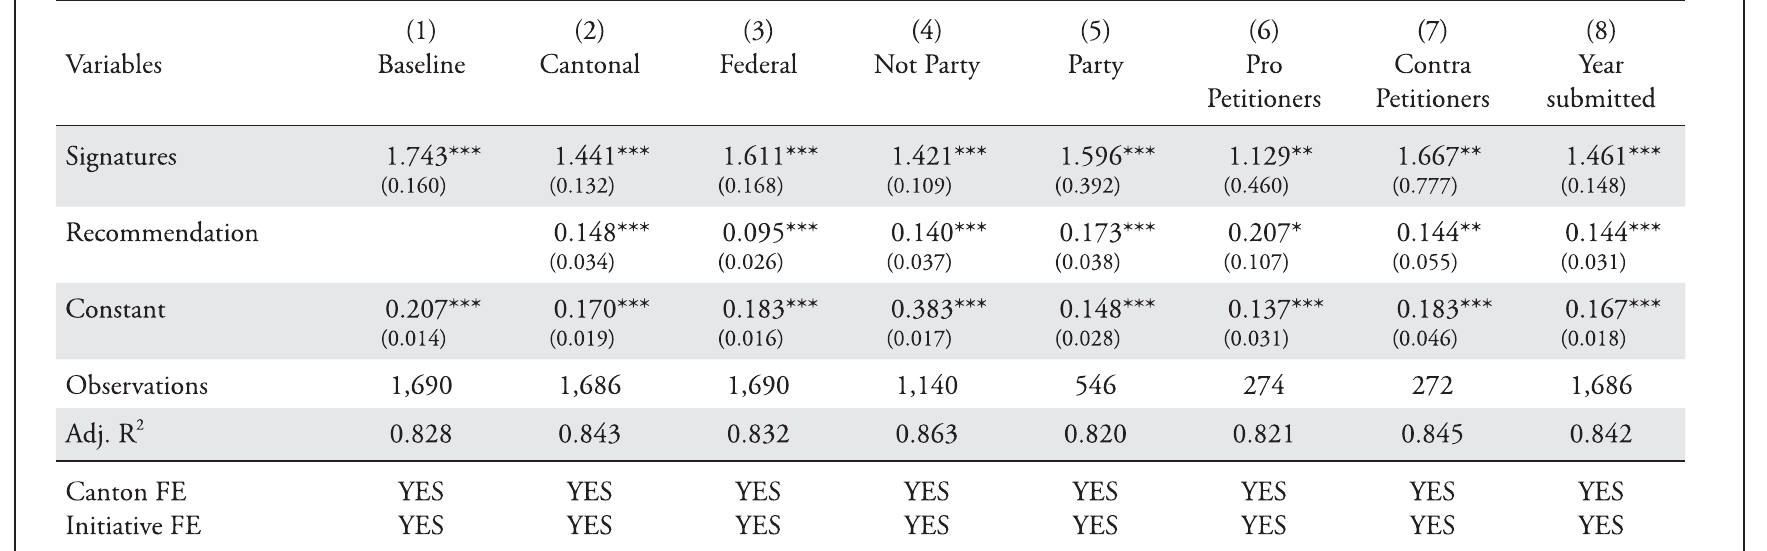
Table 3: Preferences Proxies: Party